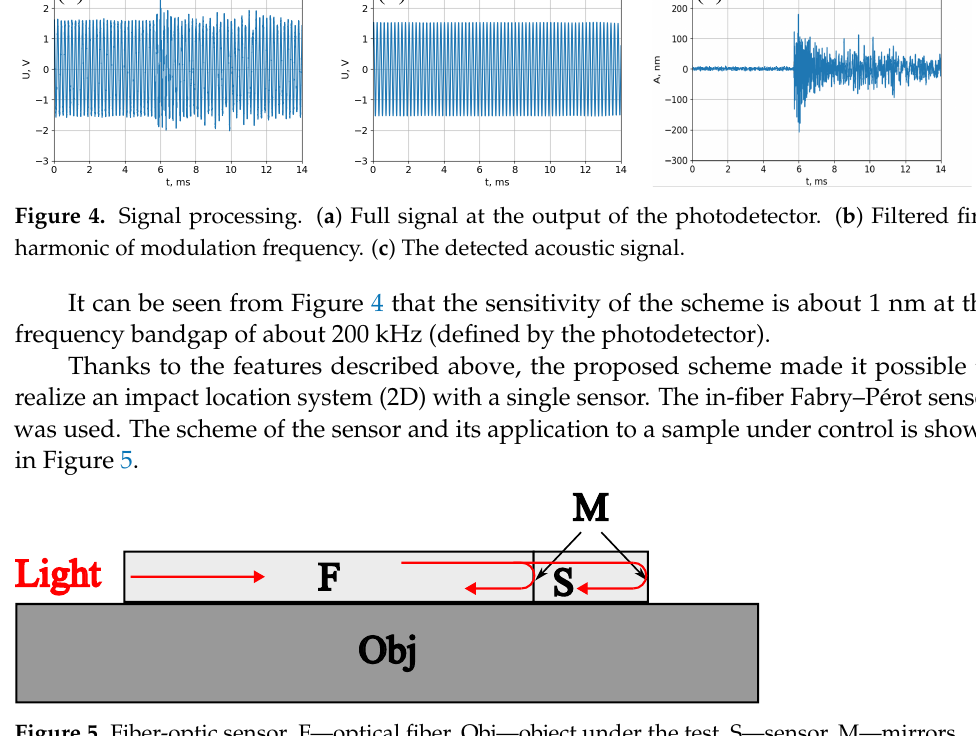
Figure 5. Fiber-optic sensor. F—optical fiber, Obj—object under the test, S—sensor,